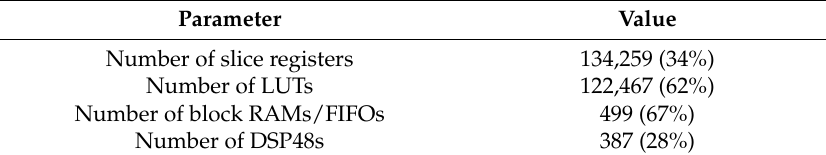
Table 5. FPGA resource occupation (Xilinx xc6vlx315t). Table 6. Actual scene imaging quality assessment.